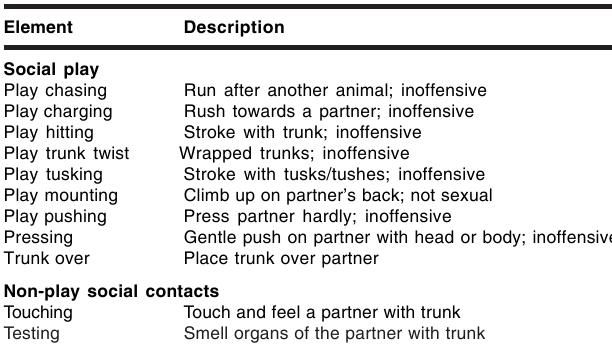
Table 1. Elements of behaviours expressed by the juvenile elephants related to the current study.